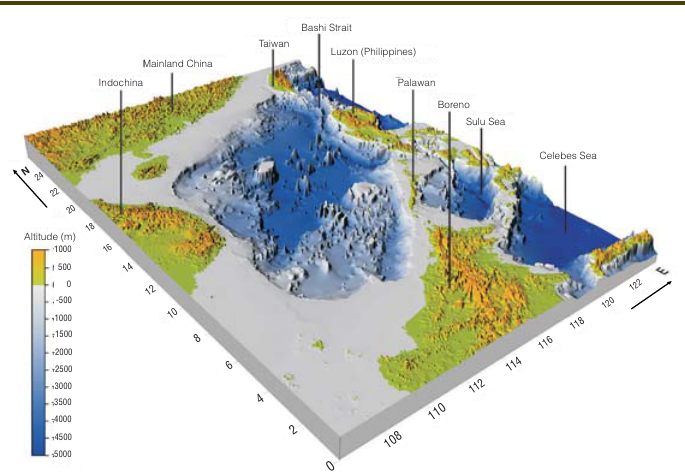
Figure 2. A 3D view of the Southeast Asia topography and South China Sea bathymetry (from Wang and Li,